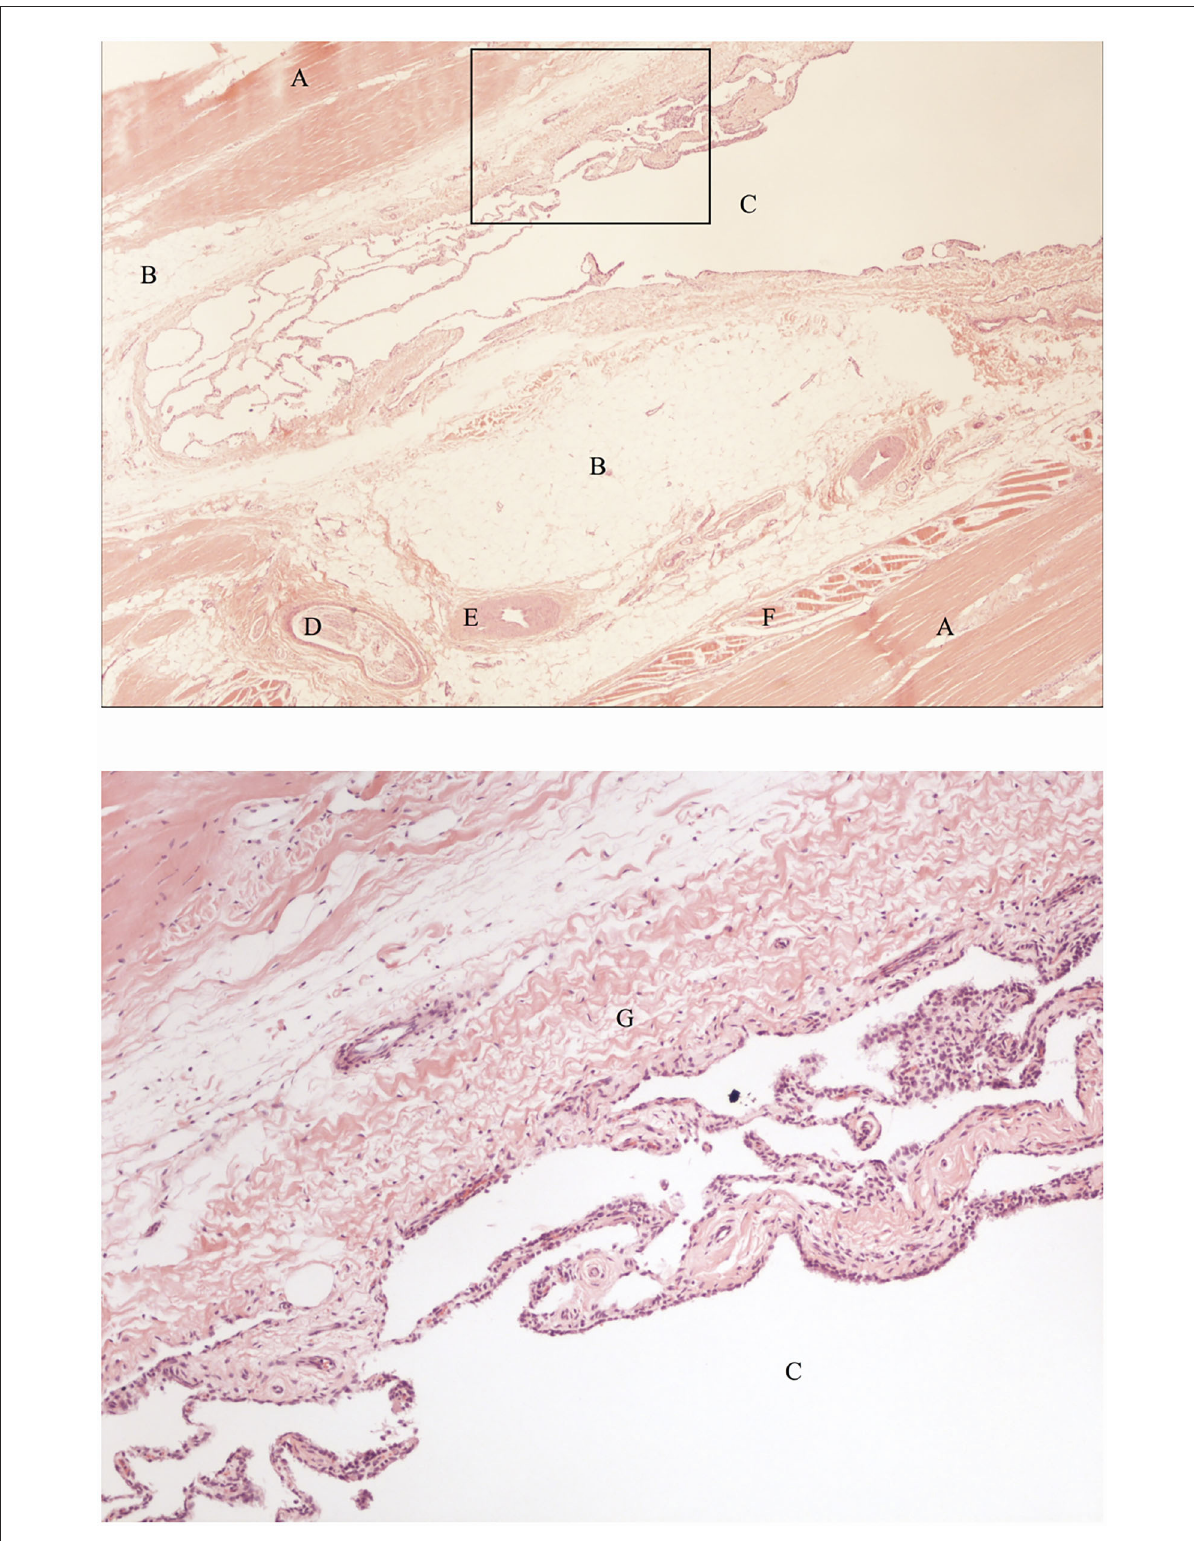
FIGURE5 Histological sections of the SL region indicated by the black arrow in Figure 4, showing a synovial lined cavity within the SL (hematoxylin and eosin). The bottom image is an enlarged section of the the image on top (indicated by the black box) showing details of the histological appearance of the synovial lined cavity. A: fibrous tissue, B: adipose tissue, C: synovial lined cavity, D: nerve, E: artery, F: muscle tissue, G: subsynovial connective tissue